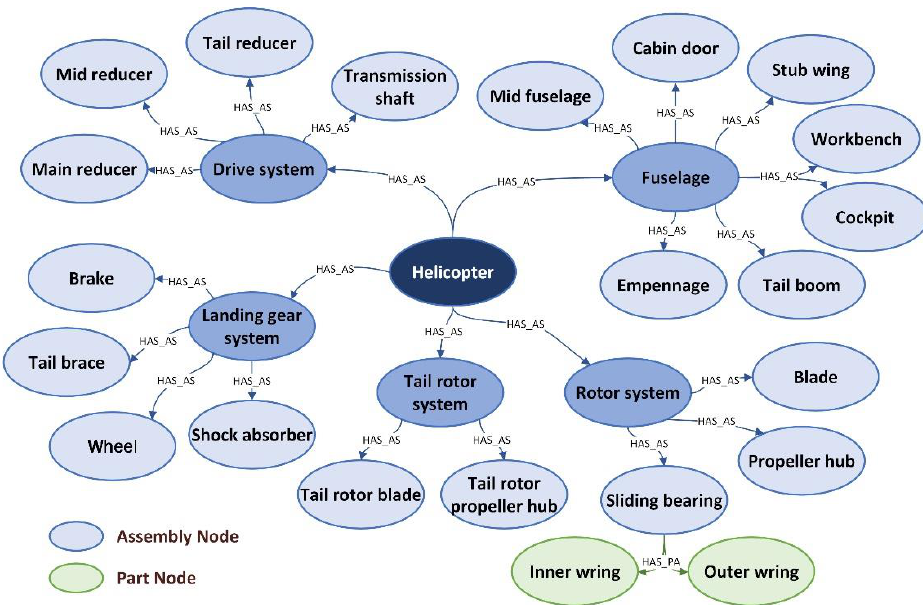
Figure 5. Schematic diagram of the hierarchical digital model about a helicopter in a graph database.